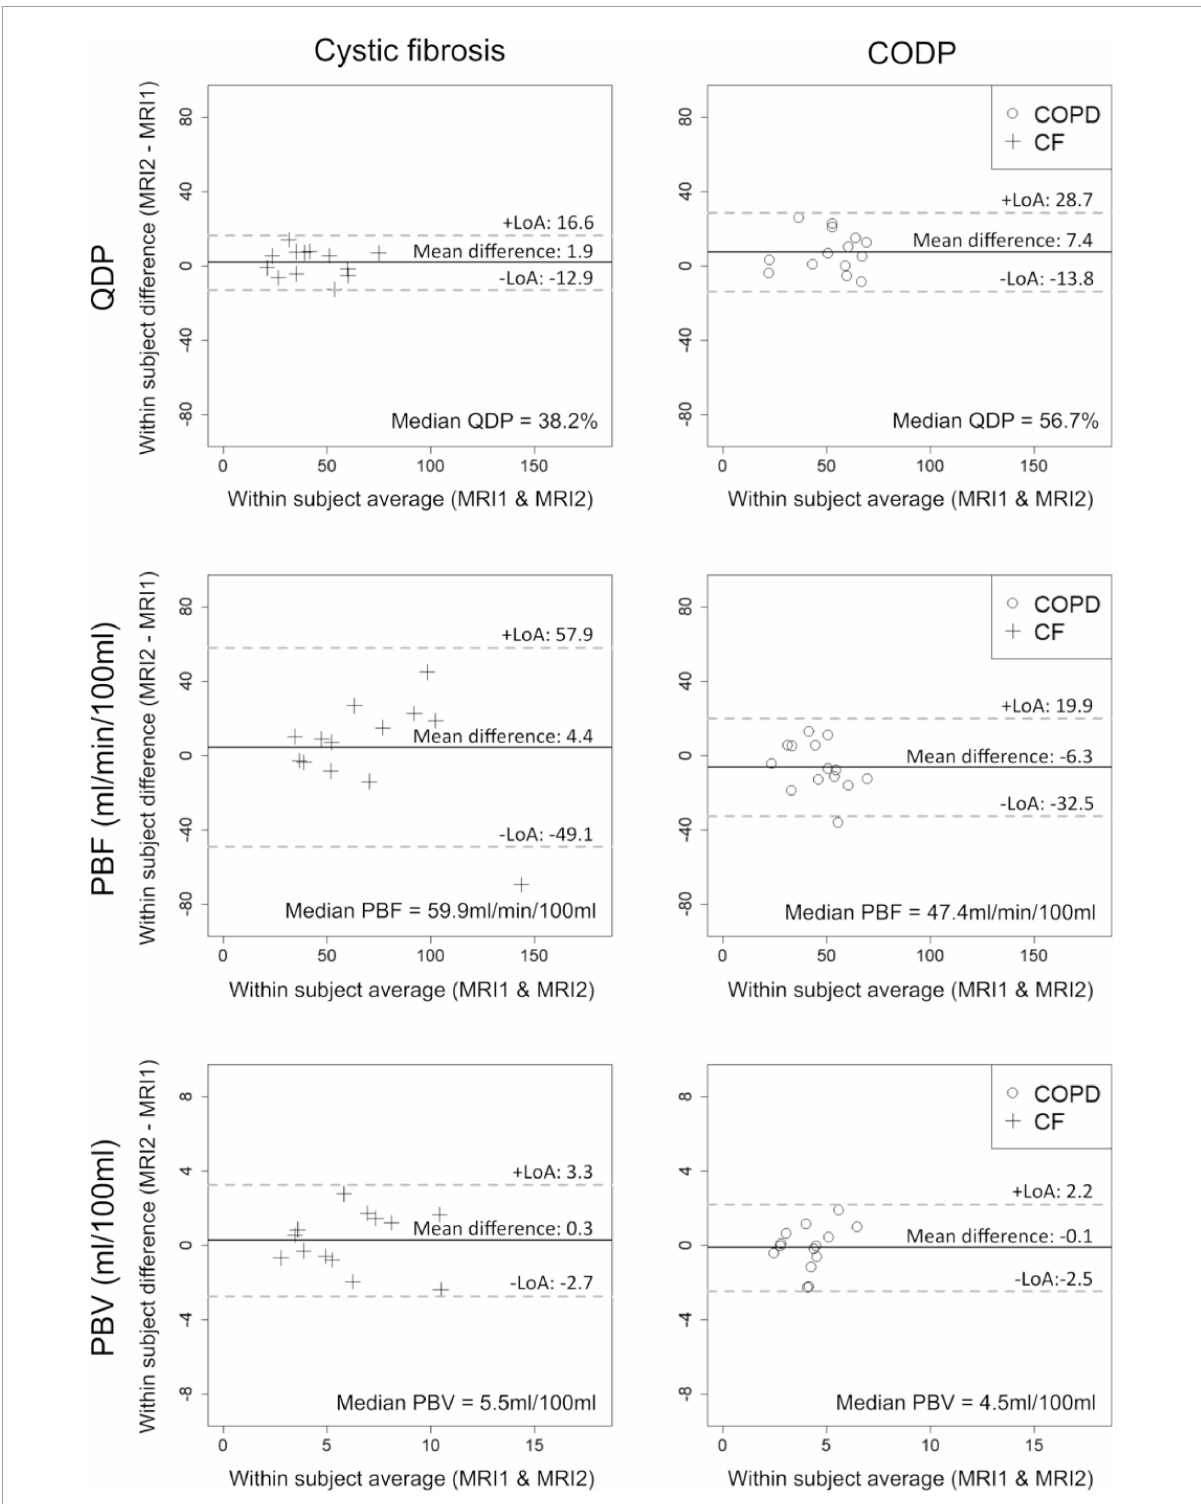
FIGURE2 Bland-Altman plots showing the midterm reproducibility of pulmonary perfusion defects in percent (QDP), pulmonary blood flow (PBF) and pulmonary blood volume (PBV) in adults with clinically stable cystic fibrosis (CF, crosses) and chronic obstructive pulmonary disease (COPD, circles). 13 CF patients and 14 COPD patients were evaluated. Mean differences, limits of agreement (LoA) and median values are given for each panel. Solid lines indicate the mean difference between MRI1 and MRI2, dashed lines the LoA ( ± 1.96* SD